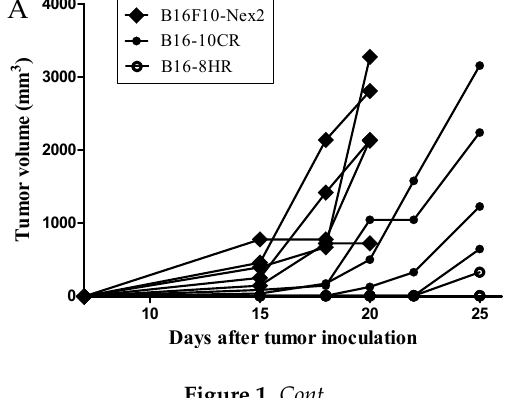
Figure 1. Cont. Figure 1. Cont .